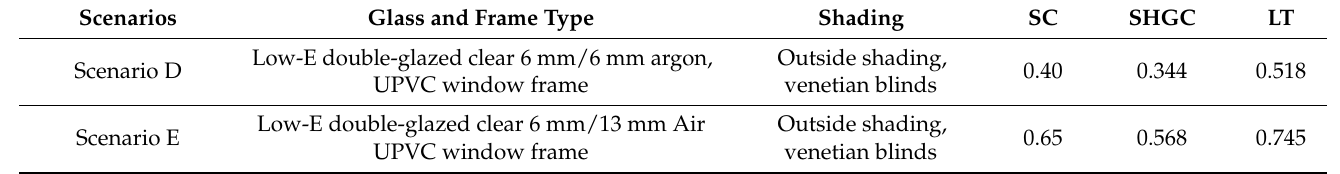
Table 5. List of solar control scenarios. UPVC = unplasticised polyvinyl